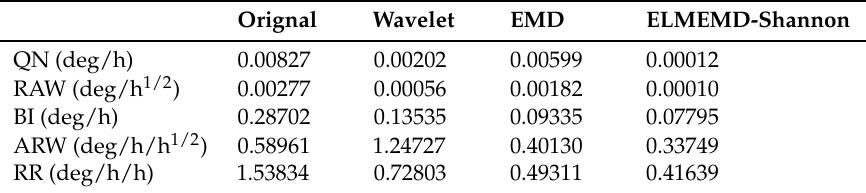
Table 1. Errors of the x -axis gyro signal.